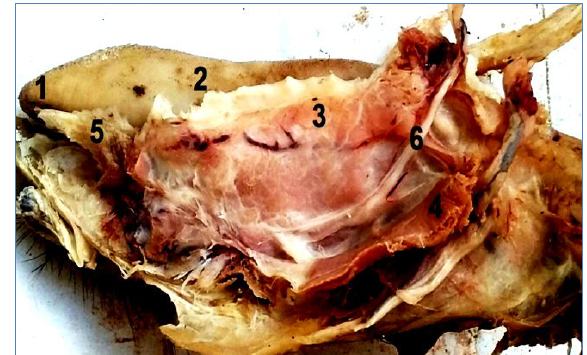
Figure, 2: Morphological view show: Apex (1) body (2) lingual salivary gland (3) myohyodius muscle (4) lingual frenulum (5) sublingual nerve (6).